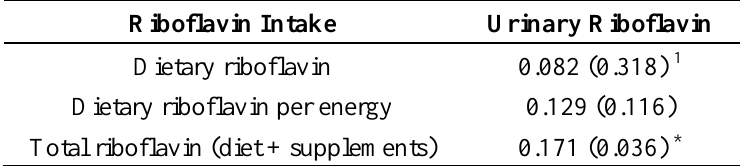
Table 5. Correlations between riboflavin intakes and urinary riboflavin excretion. Riboflavin